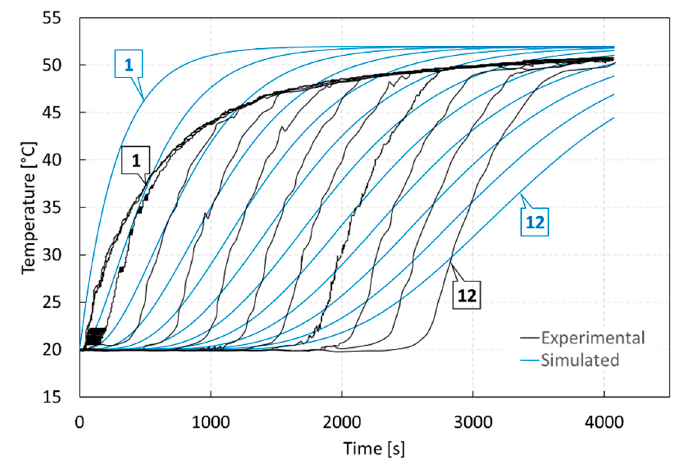
Figure 7. Temperature evolution during the charge phase—experimental vs. simulated (12 nodes).